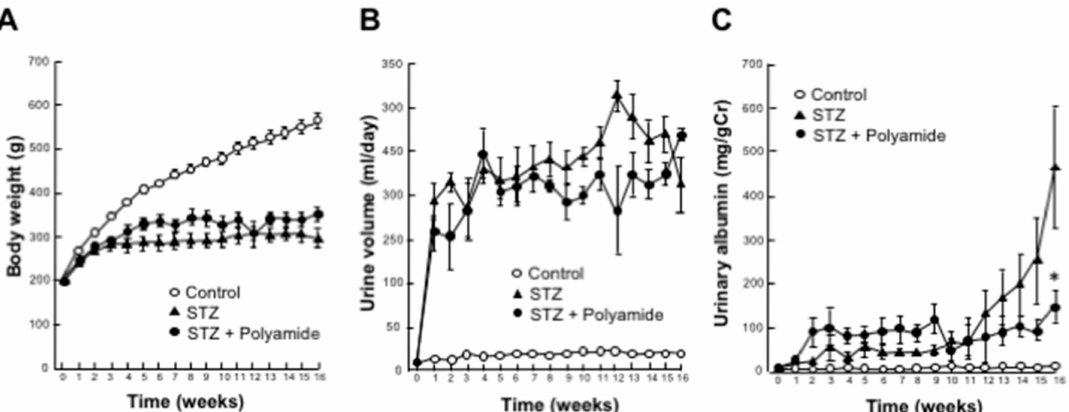
Figure 6. Effects of upstream stimulatory factor 1 (USF1) pyrrole-imidazole (PI) polyamide on ( A ) body weight, ( B ) urine volume and ( C ) urinary albumin excretion in diabetic rats. Diabetes mellitus was induced in rats by single intraperitoneal injection of streptozotocin (STZ). STZ-induced diabetic rats were intraperitoneally injected with 1 mL of 0.1% acetic acid as control rats. Then, 1 mg/kg body weight of USF1 PI polyamide dissolved in 1 mL of 0.1% acetic acid was intraperitonially injected twice a week for 4 months. Urinary albumin was measured in 24 h urine collected in metabolic cages for 4 months. Data are the mean ± SEM ( n = 6). * p < 0.05 between STZ and STZ +